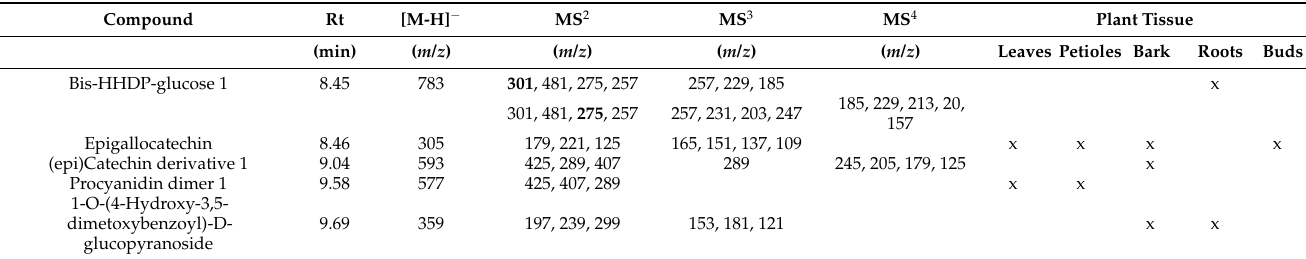
1-O-(4-Hydroxy-3,5- dimetoxybenzoyl)-D-